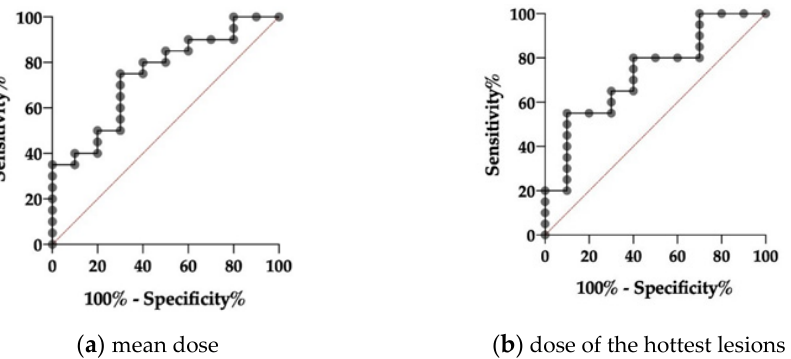
Figure 7. Receiver operating characteristics curve of averaged tumor lesions (“mean dose”, ( a )) and the index-lesion-based analysis (“hottest lesion”, ( b )) for responders and non-responders according to PERCIST criteria mean with a C-index of 0.75 and a p -value of 0.03 for the mean dose and a-with-a C-index of 0.86 and a p -value of 0.04 for the hottest-lesion dosimetry, respectively.